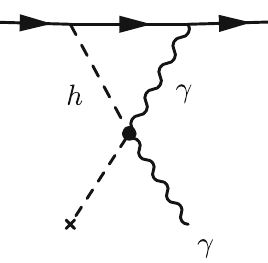
Fig. 3 Representativediagramgivingacontributionofthe H 2 F 2 class of operators to the dipole